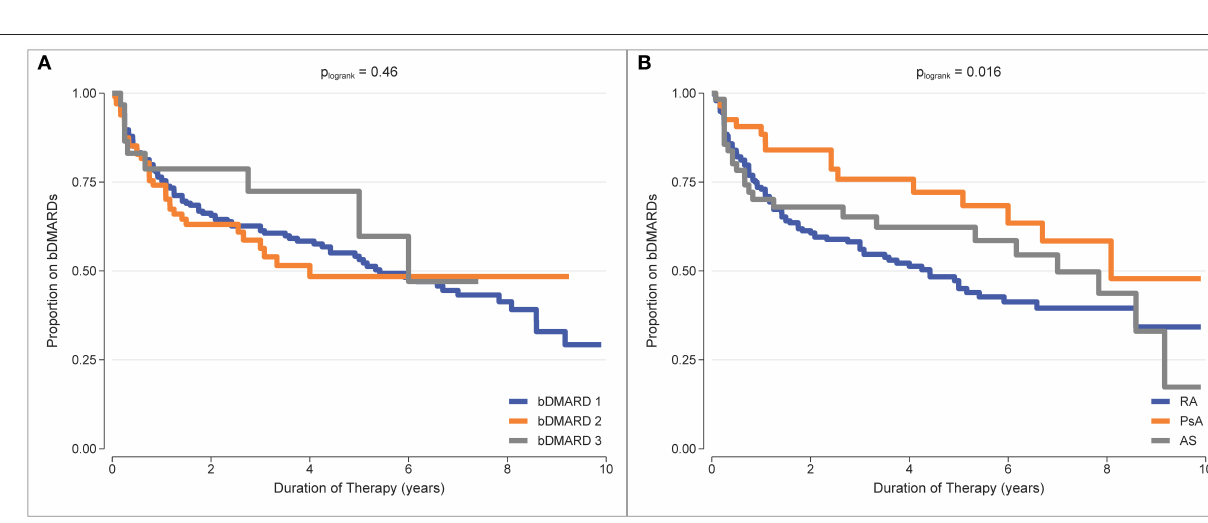
FIGURE 2 | Kaplan-Meier curves for b/tsDMARD treatment retention. (A) b/tsDMARD treatment episodes (adjusted for diagnosis group). (B) Diagnosis group (adjusted for treatment